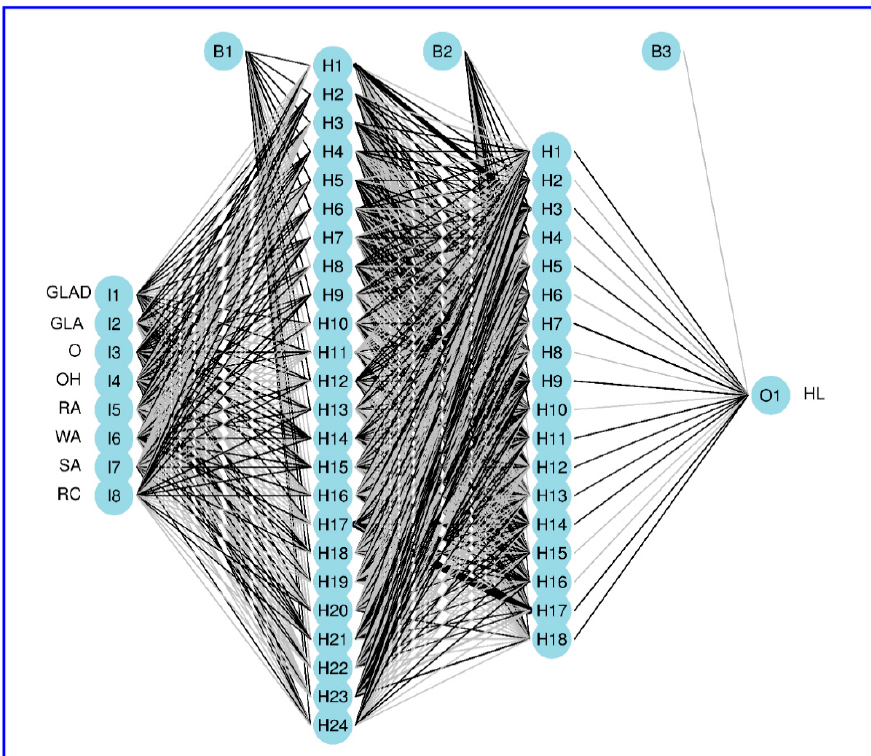
Figure 19. Structure of the ABC-ANN model for estimating HL of EEB systems.